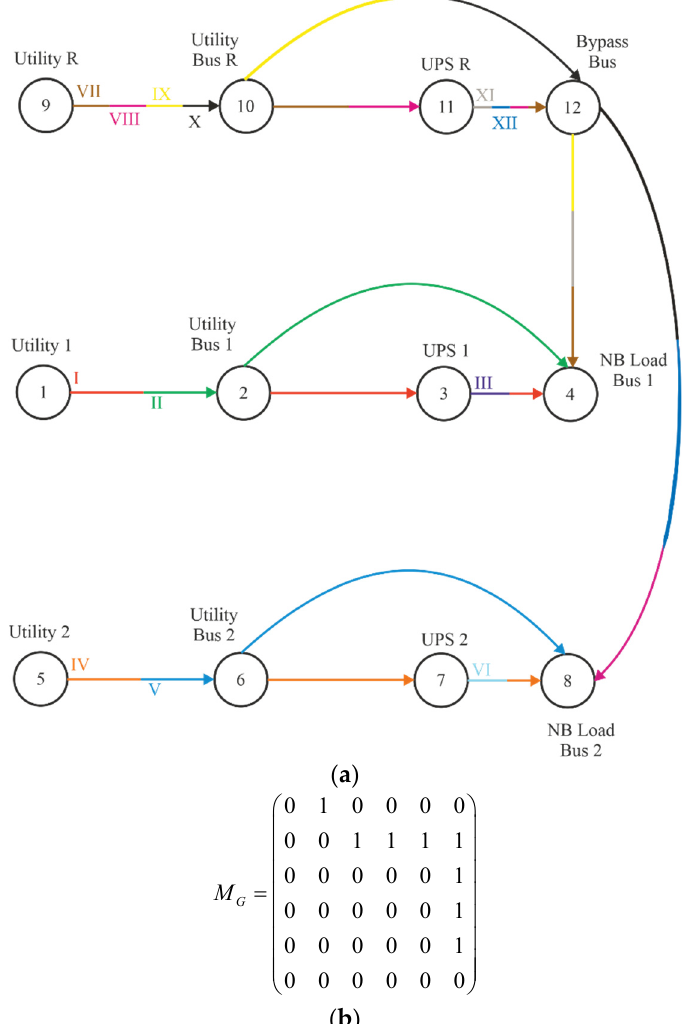
Figure 9. Configuration of Isolated Redundant: ( a ) Oriented graph; ( b ) Adjacency matrix. Table 2. Determination of operational information amount in the Parallel System.